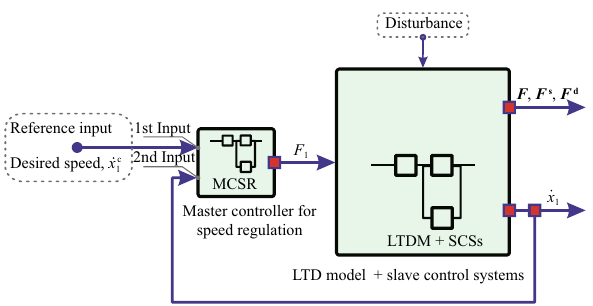
Fig. 5 Block diagram of the master control system to supervise MUT activities related to